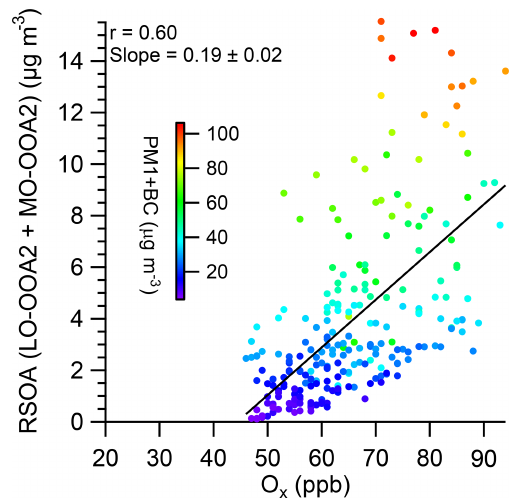
Figure 3. Scatter plot of RSOA vs. O x during the daytime (10:00– 16:00) in the early spring of 2019. Note that the fitting for the RSOAs includes LO-OOA2 and MO-OOA2, which exhibited a good correlation with O x shown in Fig.